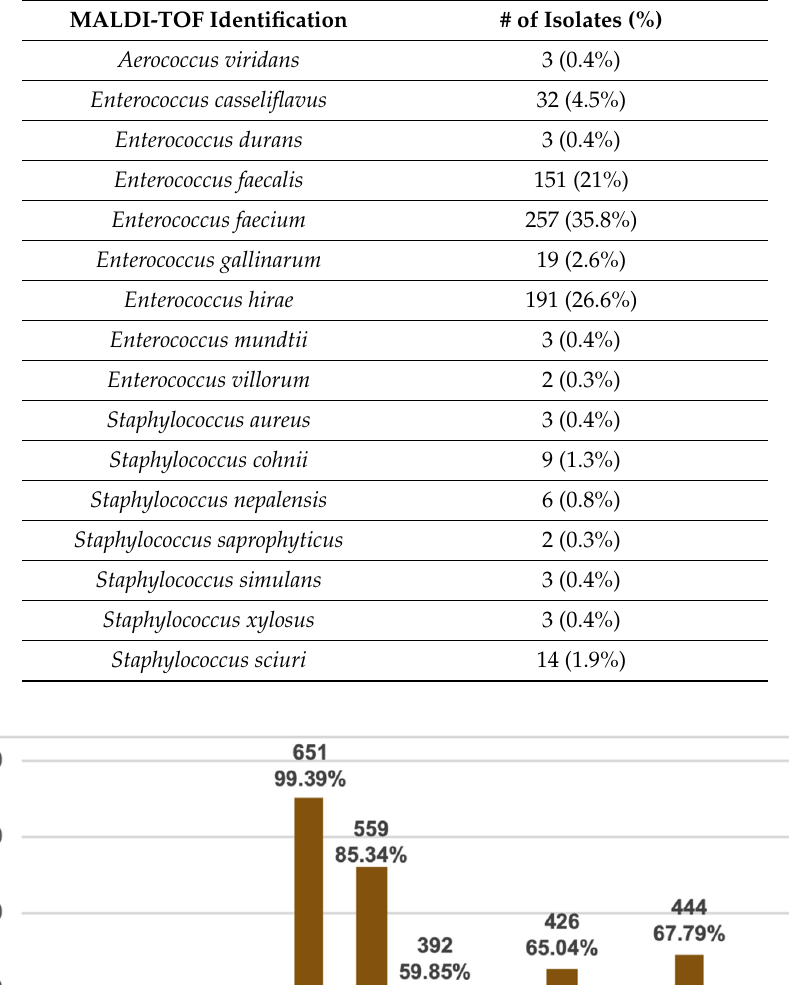
Table 1. MALDI-TOF identifications of the 718 presumptive Enterococcus spp. isolates initially isolated on Enterococcosel Agar supplemented with 4 µ g / mL erythromycin. Of these, 658 of the isolates returned a MALDI-TOF identification of Enterococcus spp. For this study, genus and species identifications of isolates that returned a MALDI-TOF MS score of 1.7 or greater were accepted, although it should be noted that a score of 2.3 or above designates a “highly probable species identification,” a score between 2 and 2.299 denotes a “secure genus identification” and “probable species identification,” a score between 1.7 and 1.999 indicates a “probable genus identification,” and a score of less than 1.7 signifies no reliable identification could be determined, according to the manufacturer.